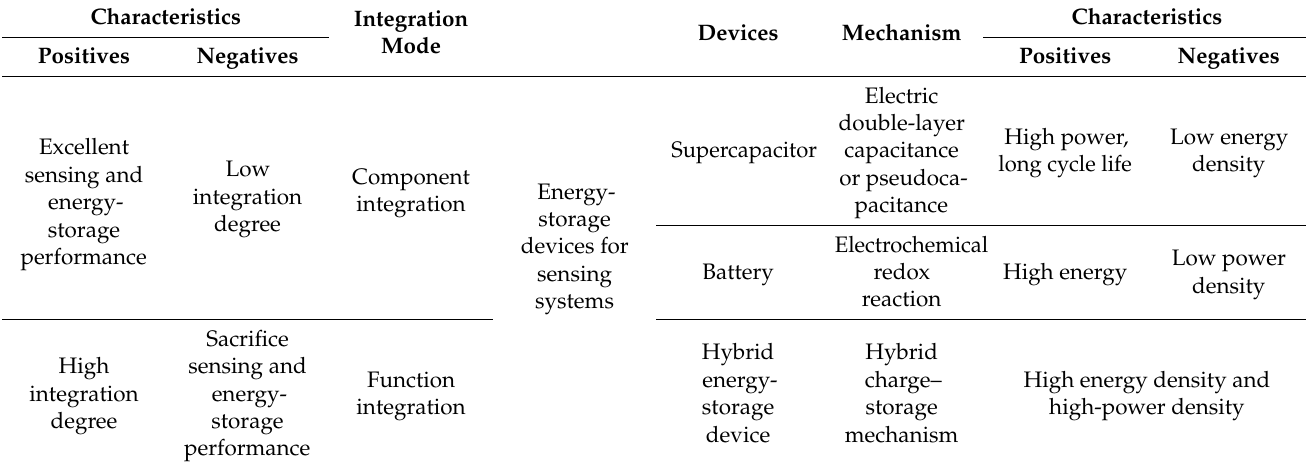
Table 1. Comparison of energy-storage devices and their integration modes for sensing